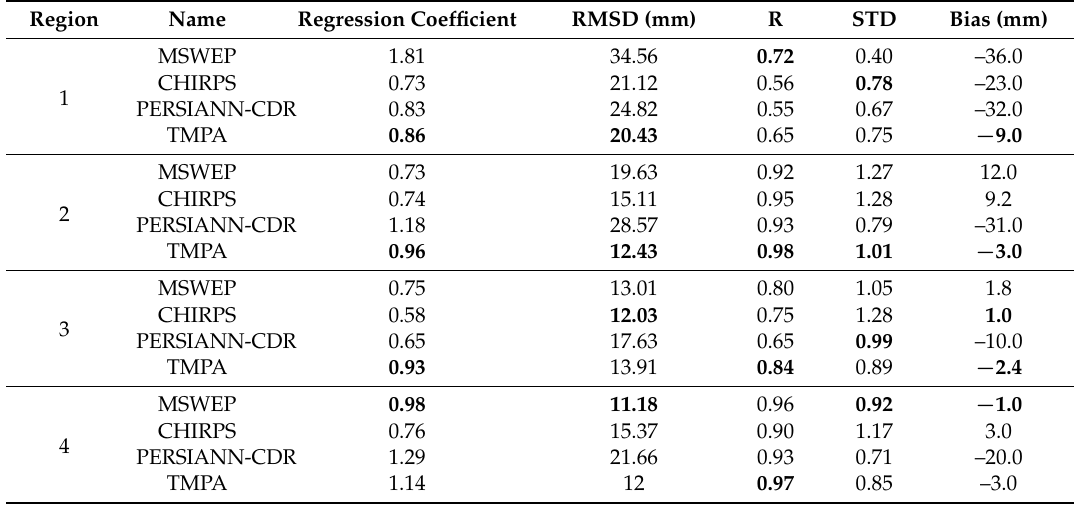
Table 2. Descriptive statistics of GPPs versus in-situ precipitation at monthly time